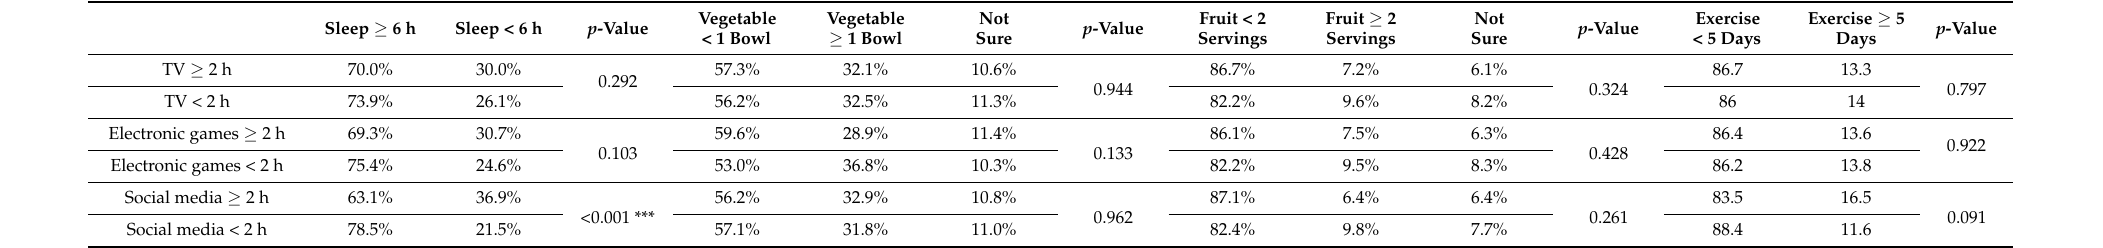
Table 2. Correlations between time spent on electronic media and sleeping time, vegetable intake, fruit intake, and exercise